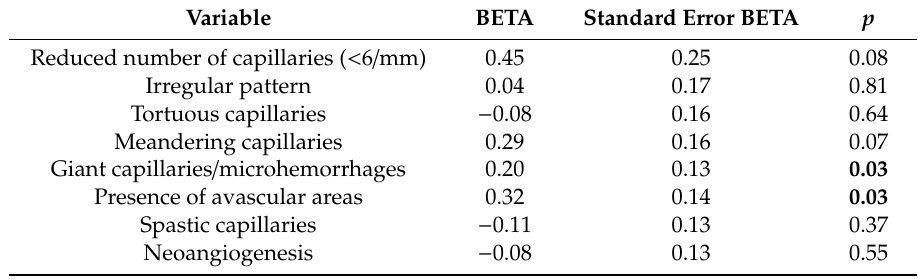
Table 10. Factors (capillaroscopic parameters) determining high-sensitivity c-reactive protein (hsCRP) concentration in the study group (determination coe ffi cient R 2 =